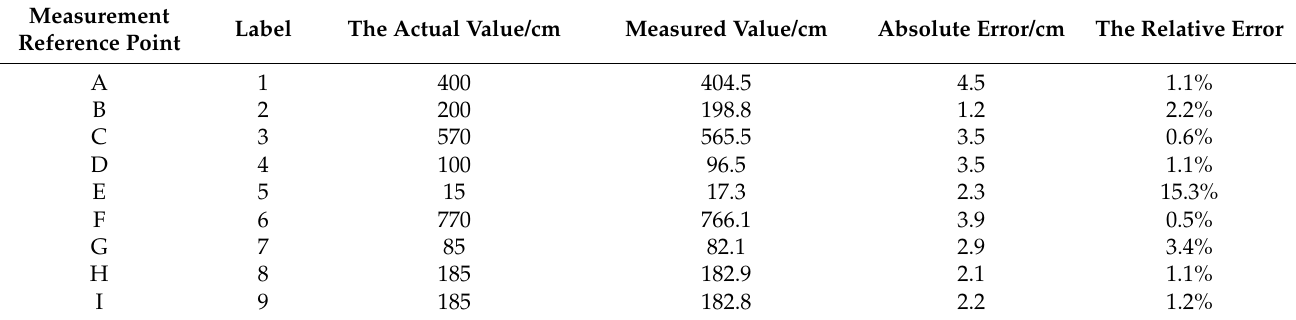
Table 6. Measurement data with a particle count of 40.